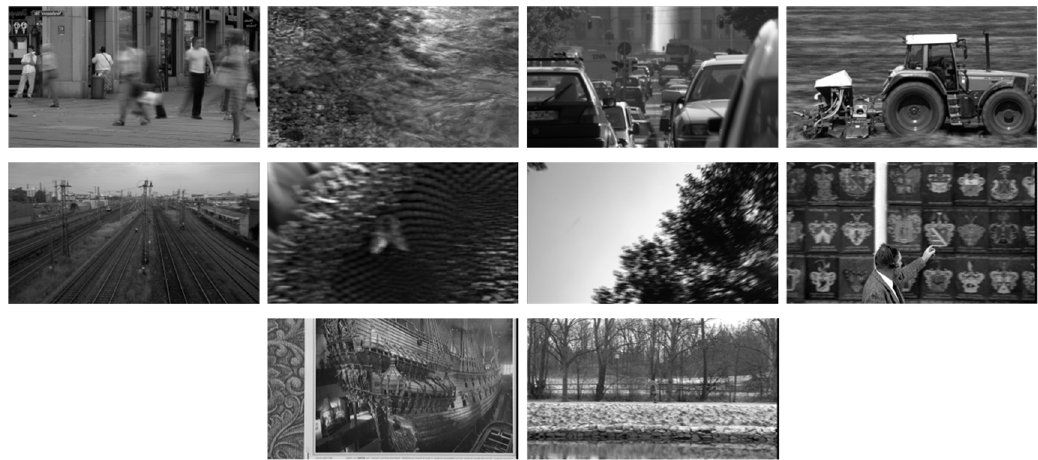
Fig 4. Training set from randomly selectedtemporal